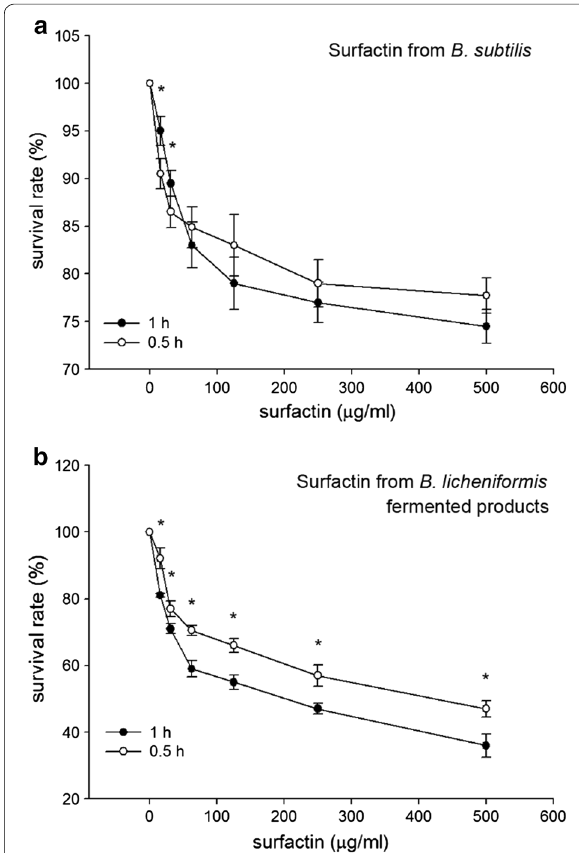
Fig. 5 Killing activity of surfactin against C. perfringens . a C. perfringens were incubated with different concentrations (7.8, 15.62, 31.25, 62.5, 125, 250, 500 μg/ml) of the B. subtilis ‑derived surfactin for 0.5 and 1 h. b C. perfringens were incubated with different concentrations (7.8, 15.62, 31.25, 62.5, 125, 250, 500 μg/ml) of the